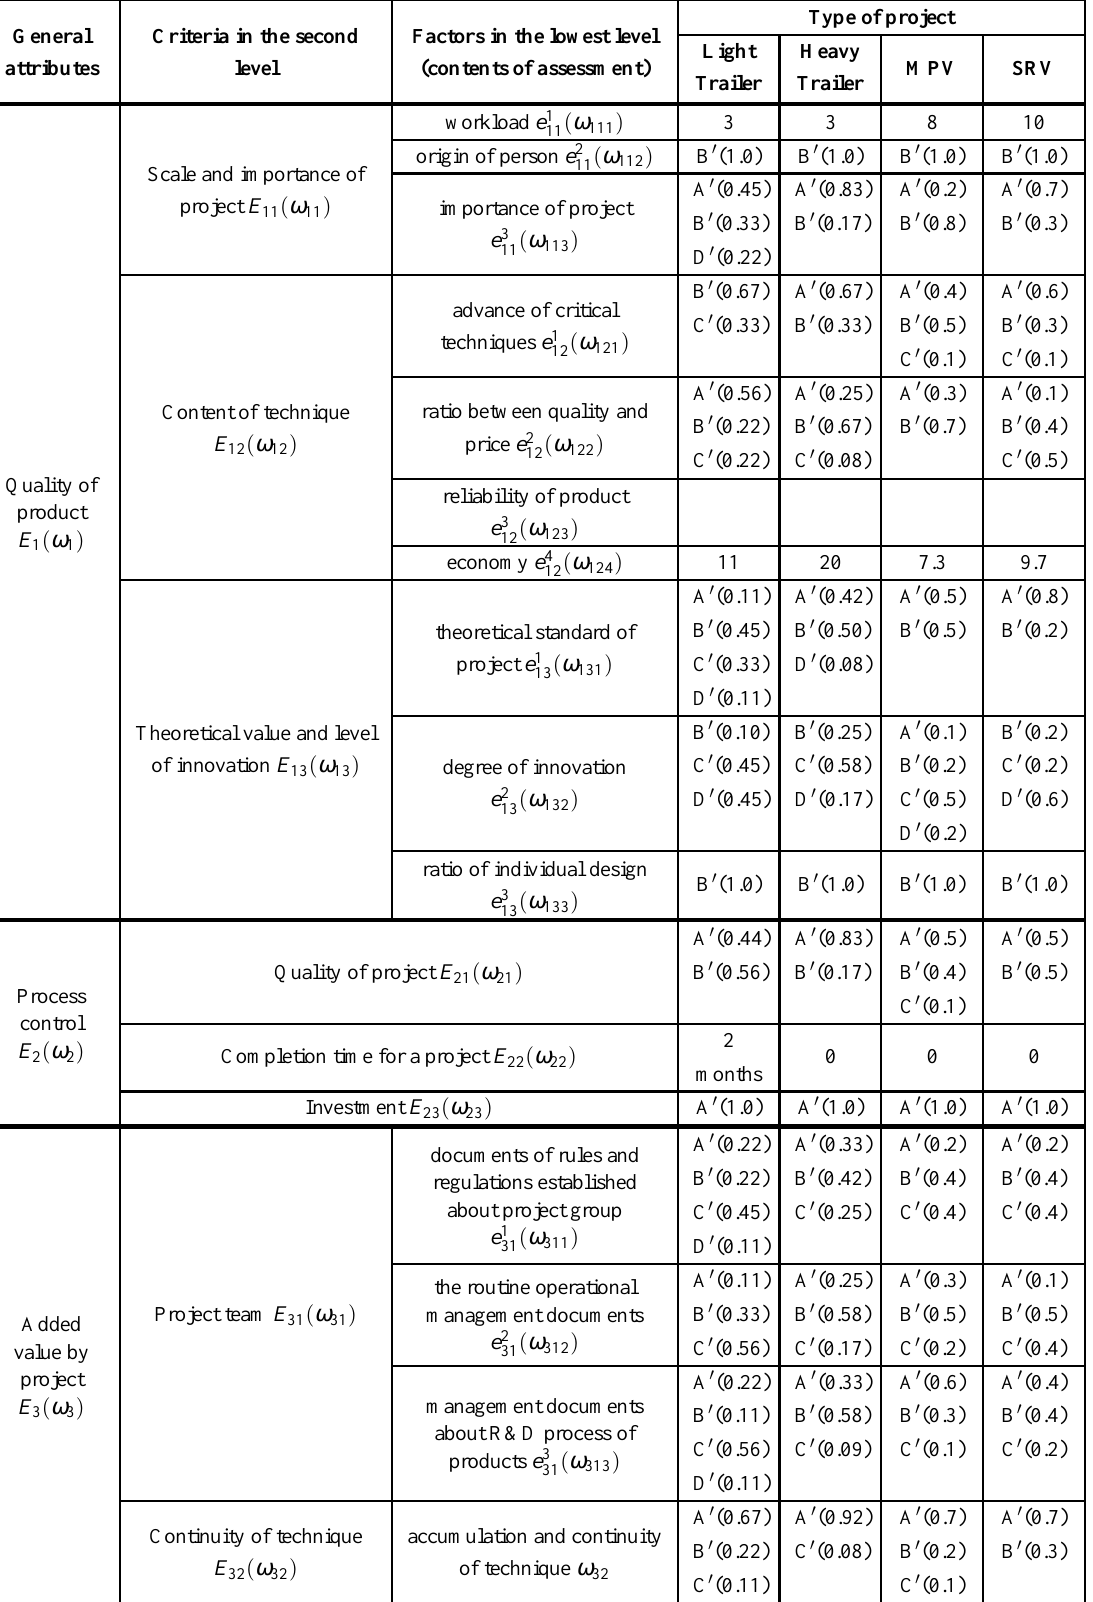
Table 12. The standard table for checkout and assessment system of strategic R&D